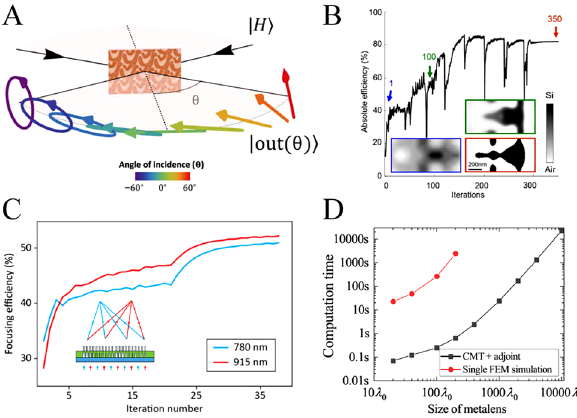
Figure 6: Some metasurface devices based on adjoint-based to- pological and shape